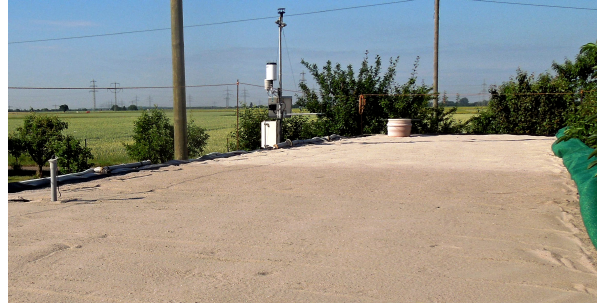
Figure 1. View of ASSESS site with tensiometer access tube, weather station, and groundwater well along the left boundary. The jump in color reveals different sands that crop out at the surface (figure adapted from Jaumann,